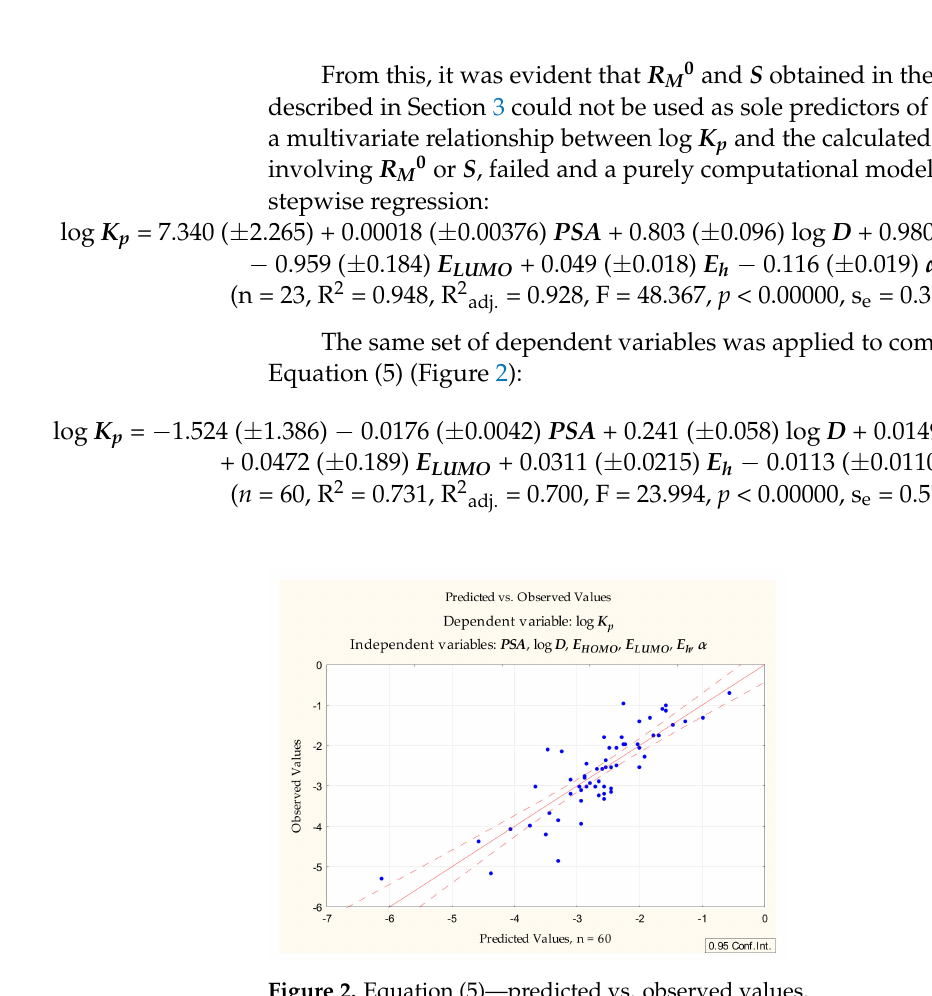
Figure 2. Equation (5)—predicted vs. observed